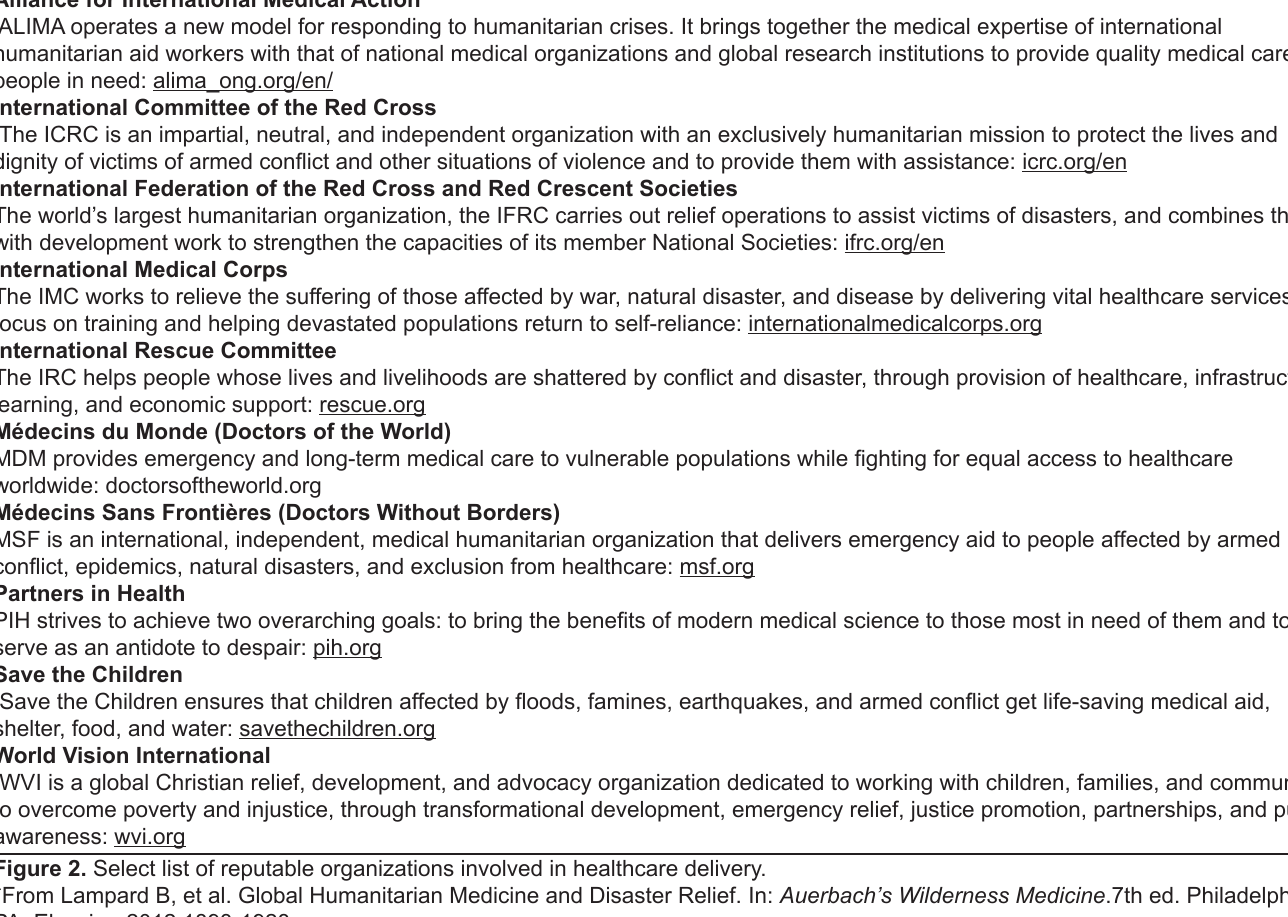
Figure 2. Select list of reputable organizations involved in healthcare delivery. PA. Elsevier;